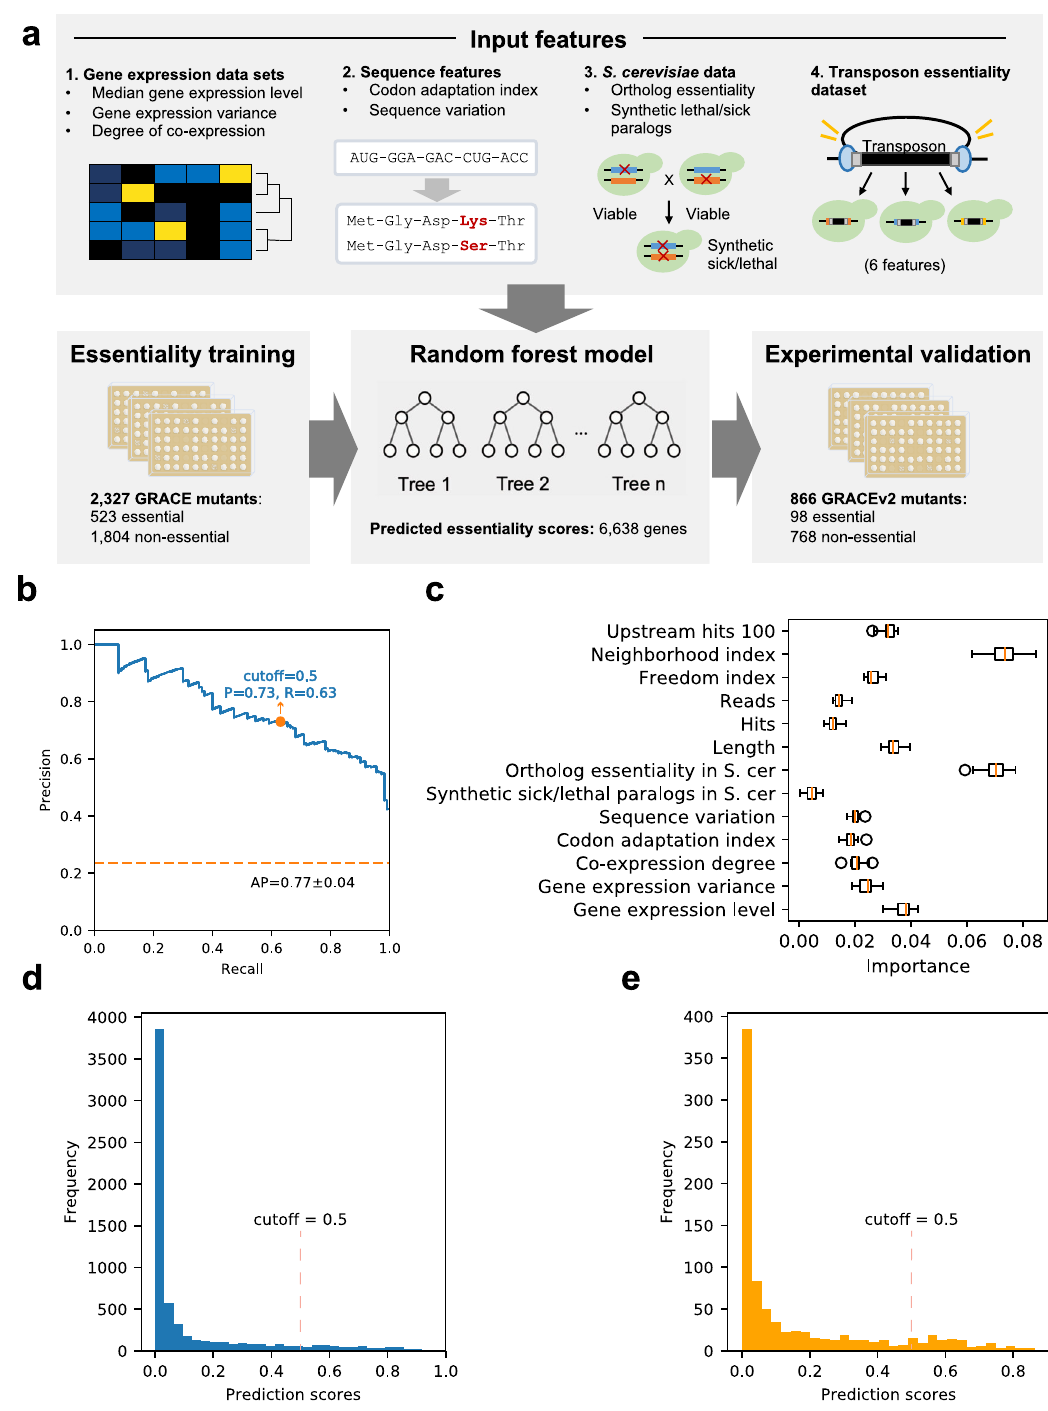
Fig. 1 Building a machine-learning model to predict essentiality and testing on the original GRACE collection. a Overview of the input, output, and validation process of our random forest model. b Precision-recall curve of our random forest model on 20% of the GRACE gene set. The model was trained and optimized on the other 80% of the GRACE gene set. The default stringent cutoff score for essential gene predictions results in a precision of 0.73 and a recall of 0.63, with an average precision score of 0.77. The error bars re fl ect the standard deviation across estimates derived from 10,000 different resamplings (with replacement) of the test set. c Permutation feature importance of our random forest model for the whole GRACE gene set. The decrease in a model upon permutation of that feature score re fl ects importance, and the box plots show variation for each feature ’ s importance across 30 permutations. The whiskers extend out to 1.5 times the inter-quartile range, and the fl ier points re fl ect outliers beyond 1.5 times the inter-quartile range. S. cer represents S. cerevisiae . d Distribution of our random forest prediction scores across 6638 C. albicans genes. e Distribution of prediction scores for the 866 selected candidates for further experimental validation. Source data are provided as a Source Data fi